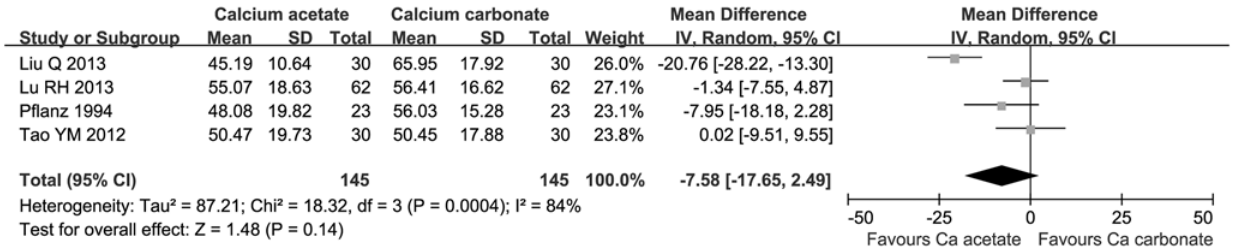
PLOS ONE | DOI:10.1371/journal.pone.0121376 March 23,